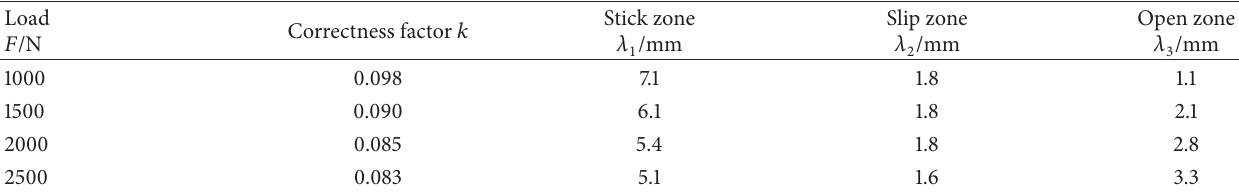
Figure 10: Contact stress distribution curves under different loads. (a) Normal contact stress and (b) tangential contact stress. Table 1: Sizes of three zones under different loads.